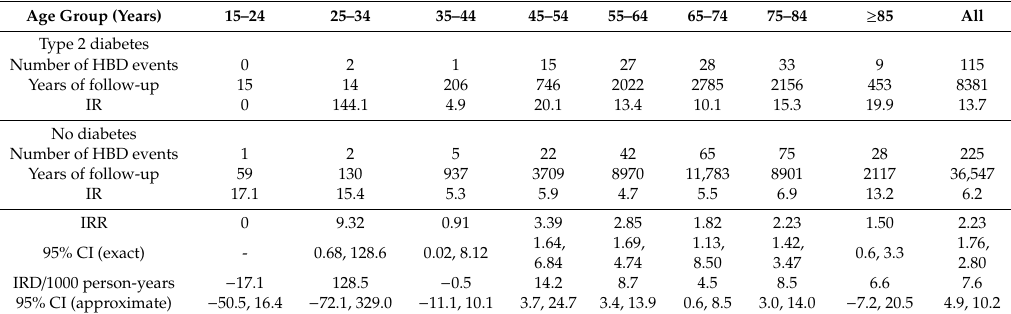
Table 7. Age-specific incidence rates (IRs) per 1000 person-years, incidence rate ratios (IRRs), and incident rate di ff erences (IRDs) for first-ever hospitalization for / with or cancer registration or death from / with hepatobiliary disease (HBD) in the Fremantle Diabetes Study Phase II cohort for type 2 diabetes versus no diabetes.